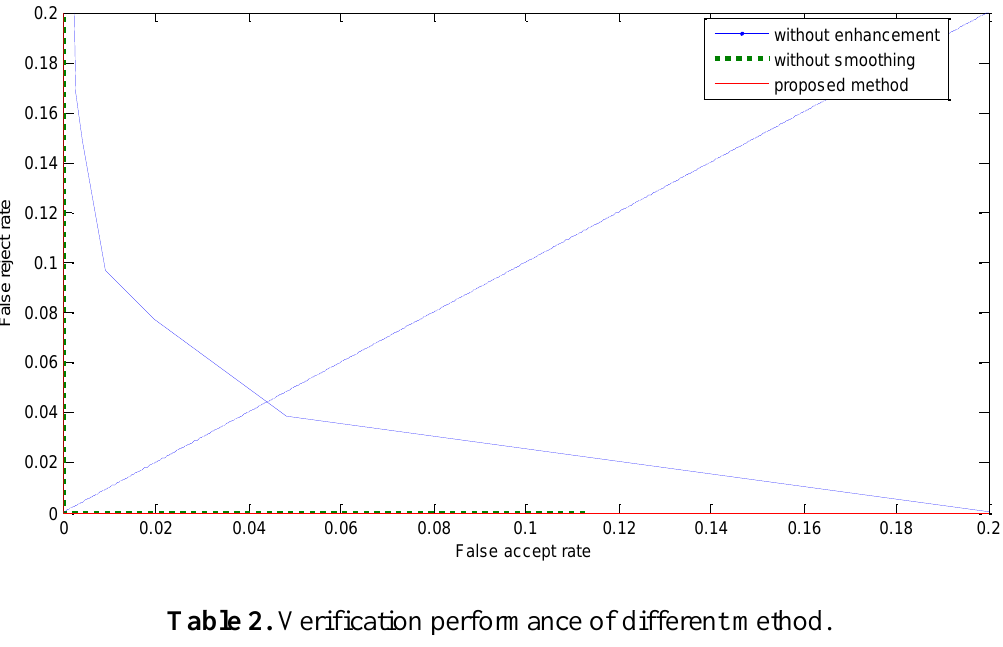
Figure 11. The ROC curve in the verification mode.